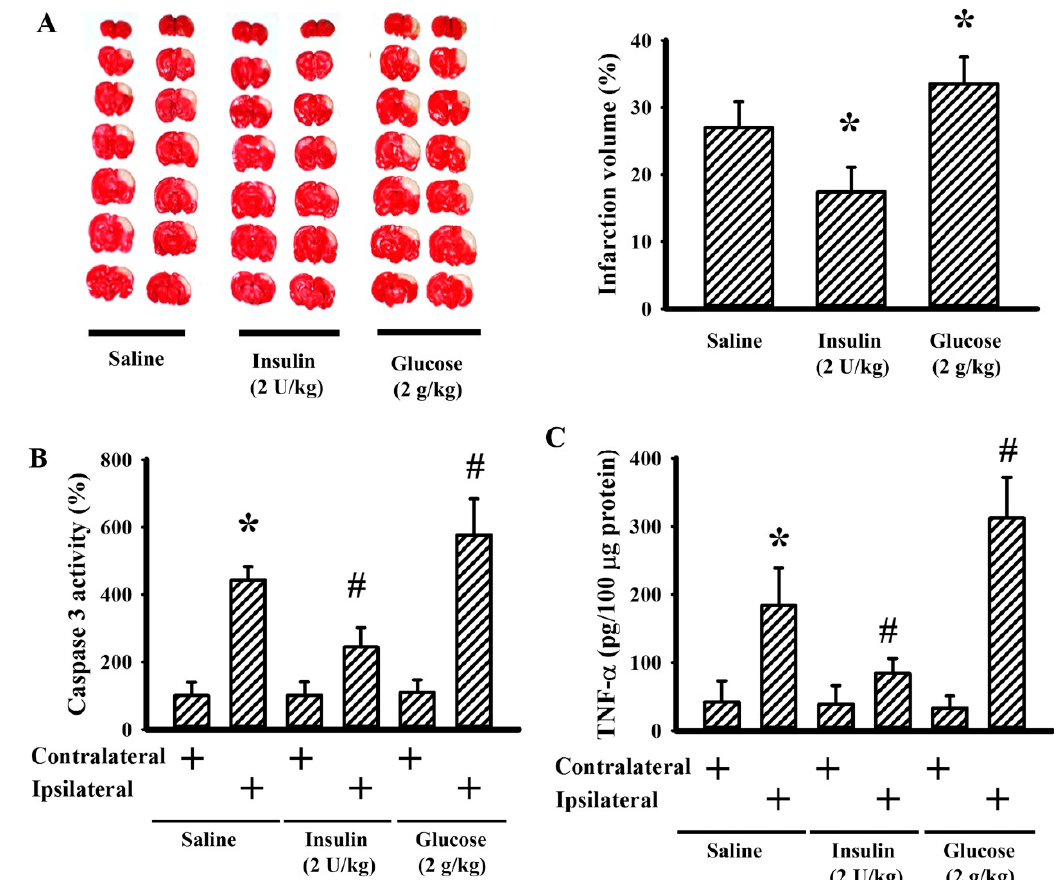
Figure 6. Insulin reduced but glucose augmented cerebral ischemia injury. Rats receiving a normal saline vehicle, insulin (2 U/kg), or a glucose (2 g/kg) intraperitoneal injection were subjected to permanent cerebral ischemia for 24 h. ( A ) Representative photographs show the histological examination of brain infarction by TTC staining. The average percentage of infarction volume in the ipsilateral hemisphere is depicted. ( B ) Proteins were extracted from the contralateral and ipsilateral cortical tissues and subjected to an enzymatic assay of caspase 3 activity. ( C ) Proteins were extracted from the contralateral and ipsilateral cortical tissues and subjected to ELISA for the measurement of TNF- α . * p < 0.05 vs. saline or the contralateral tissues of the vehicle group and # p < 0.05 vs. the ipsilateral tissues of the vehicle group, n = 6.